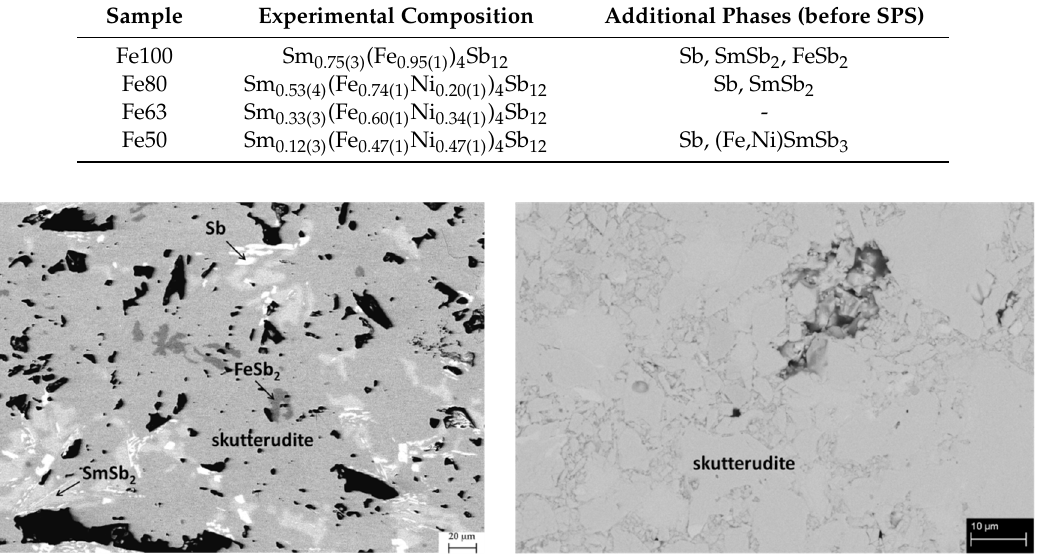
Table 1. Experimental composition and extra phases in FeXX ann samples. Experimental Composition